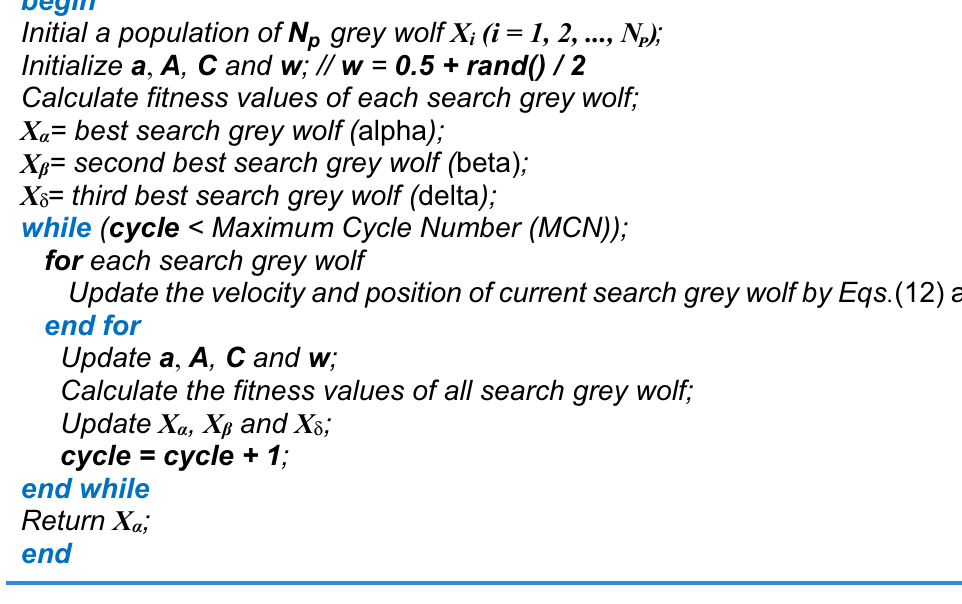
Figure 4. Pseudo-code of hybrid GWO–PSO